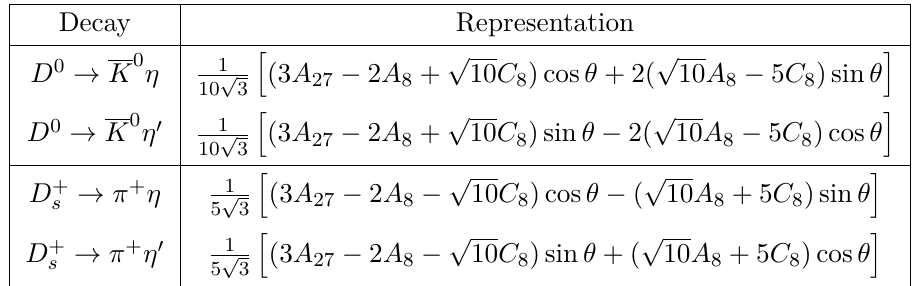
Table 1. η − η 0 decay-amplitude representations with A (1) matrix-elements